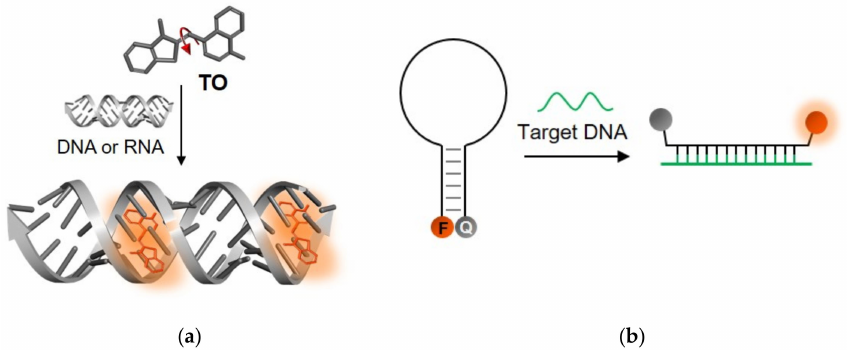
Figure 2. Comparison of nucleic acid recognition by TO and MBs. ( a ) TO’s ‘turn-on’ fluorescence results from its binding to dsDNA or dsRNA, regardless of the sequence or structure; ( b ) The operating mechanism of MBs relies on their embedded sequence, which allows for specific responses. In this illustration, recognition of a complementary target causes the hairpin structure to open up, separating the fluorophore (F) and quencher (Q) pair and yielding at ‘turn-on’